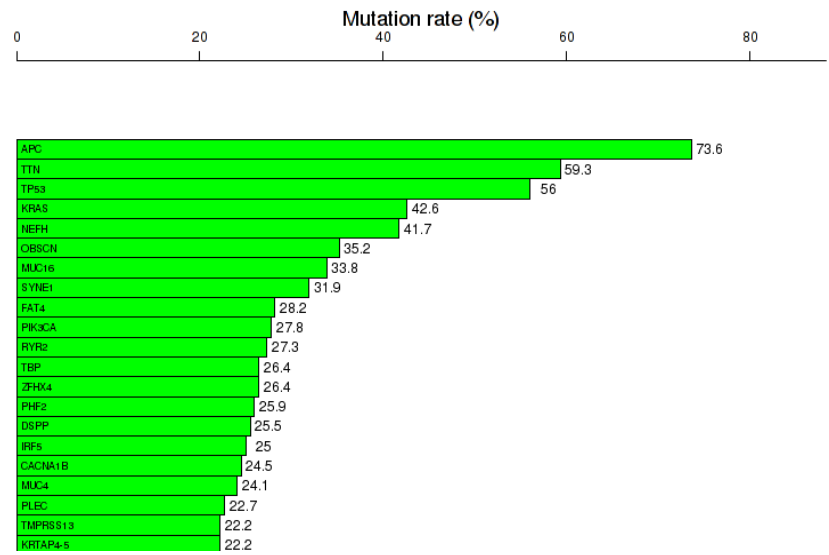
Figure 1. Mutational landscape, including the top 20 frequented mutated genes in COAD, mutation rates expressed as % from the total number of samples, generated using the online portal TCOA.